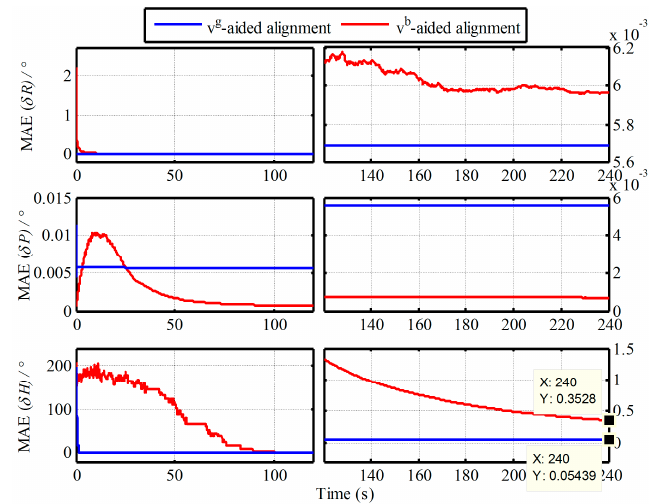
Figure 3. Curves of mean absolute deviation (MAE) of 50 alignment results.